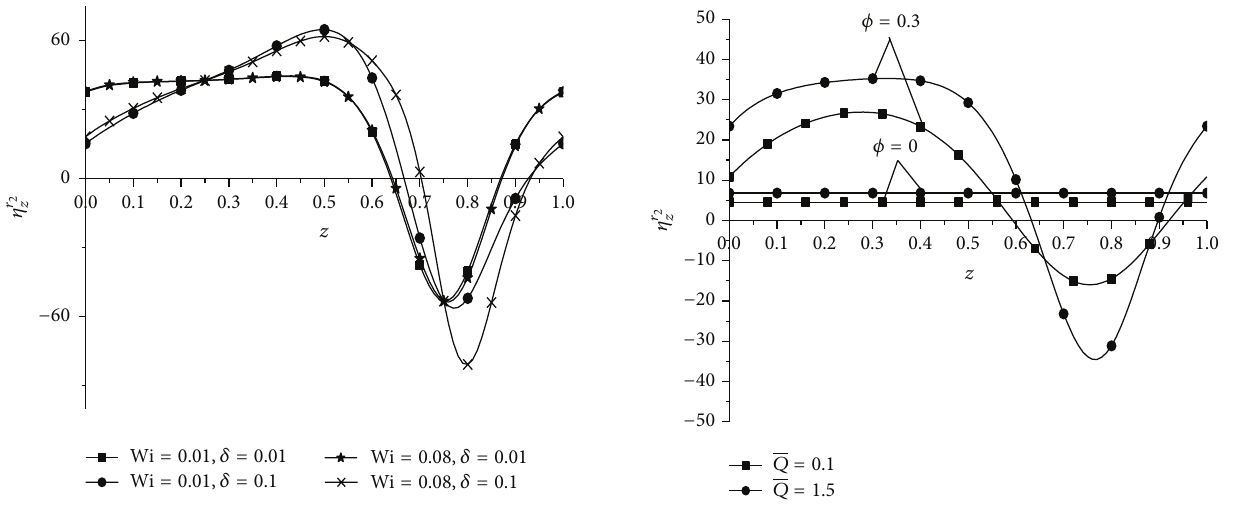
Figure6:Variationofwallvorticity 𝜂 𝑟 2 𝑧 versus 𝑧 withdifferentvalues of 𝑄 and 𝜙 at Wi = 0.02 , 𝛿 = 0.1 , 𝜖 = 0.01 , and Re = 1 .